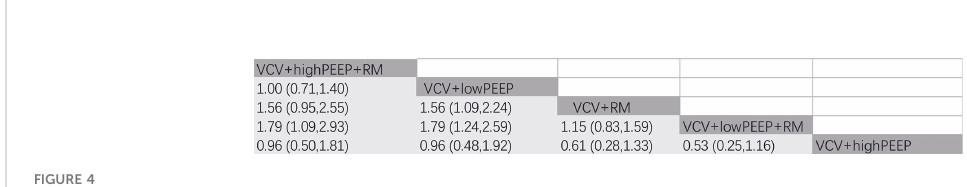
FIGURE 4 League table of pulmonary complications under different ventilation strategies.